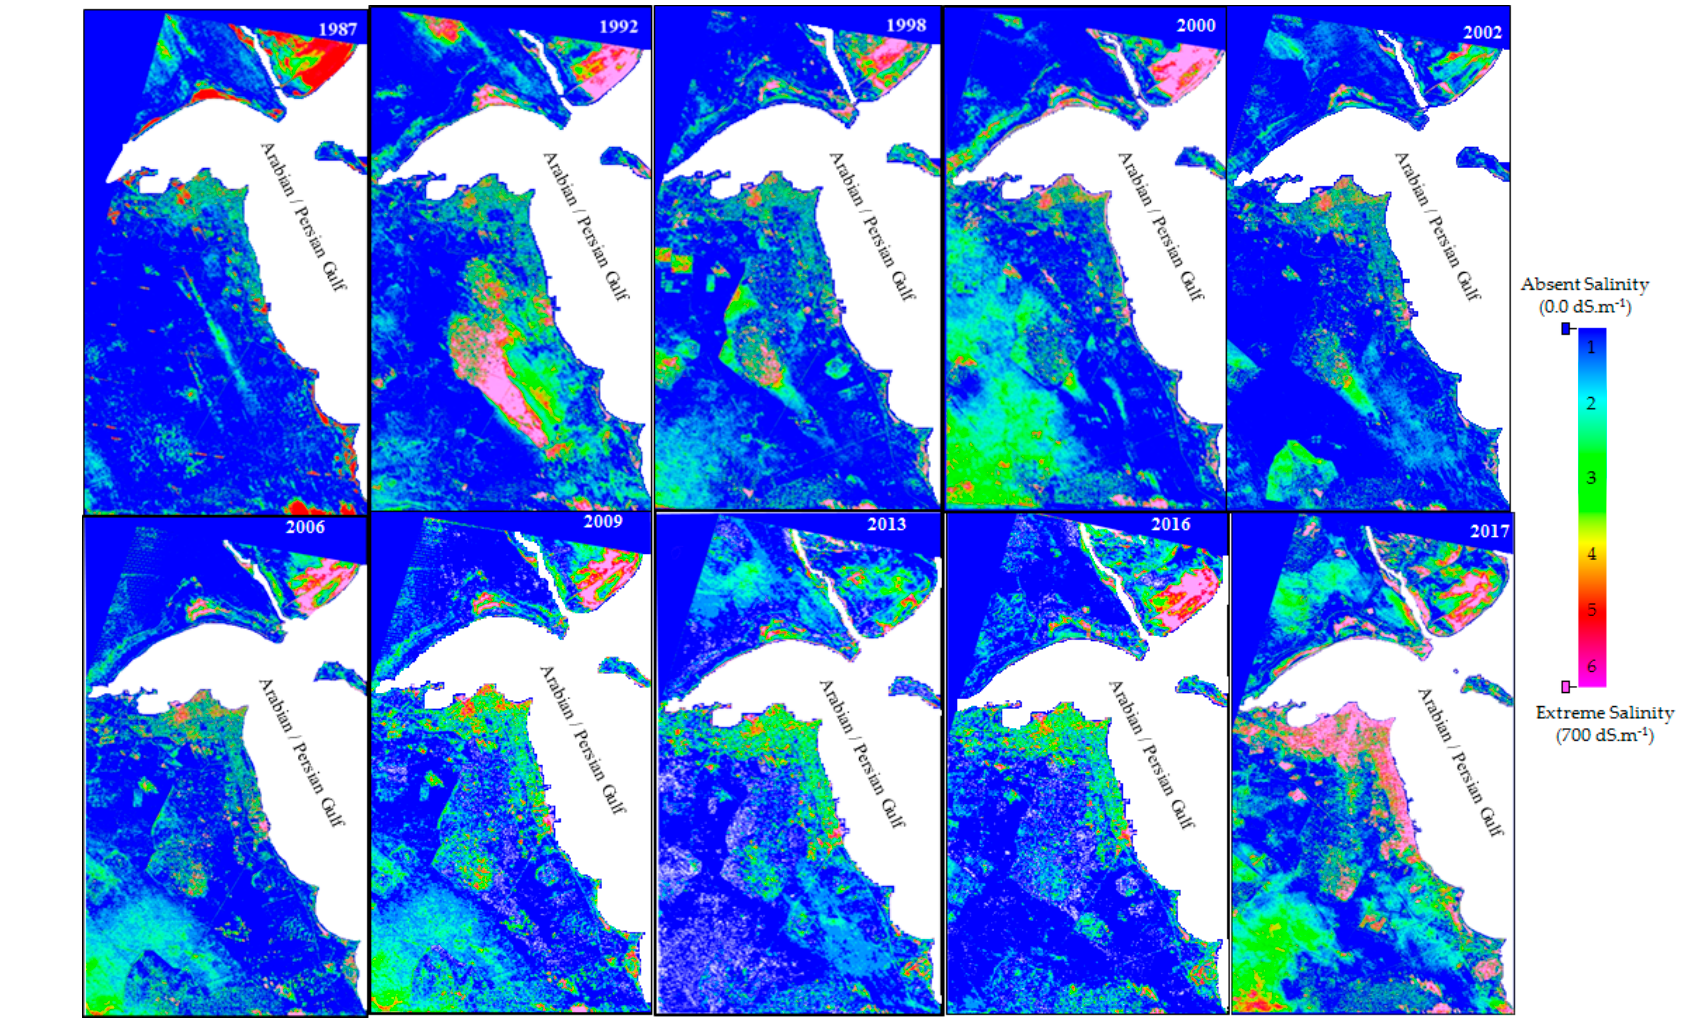
Figure 8. Three decadal change of soil salinity over the study area in Kuwait State between 1987 and 2017 (maps unit in dS.m − 1 ).